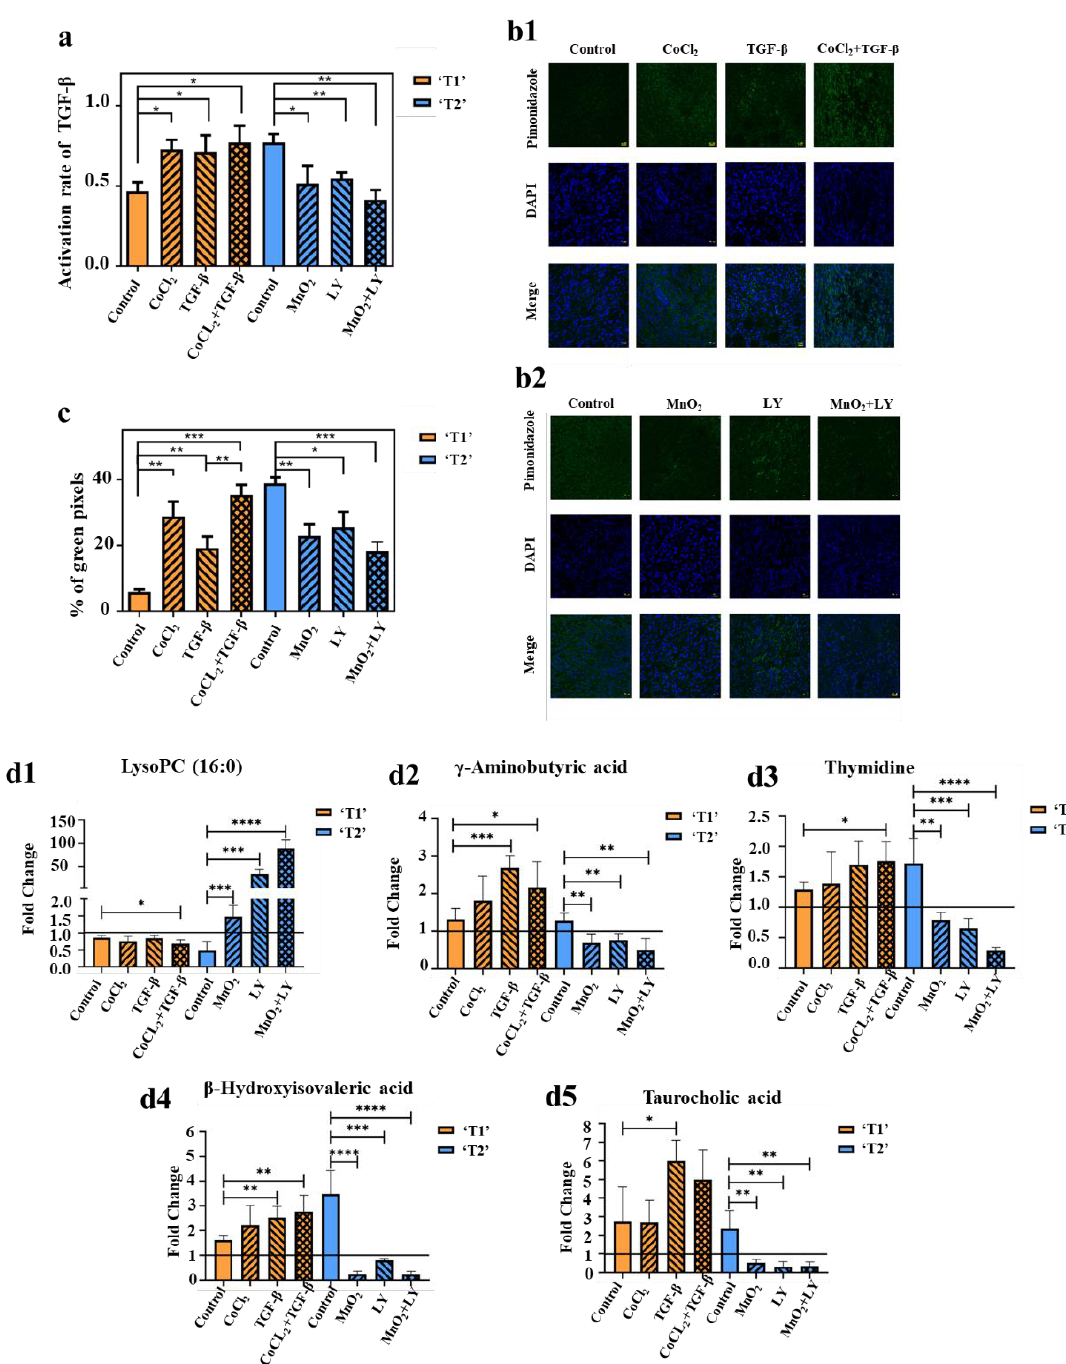
Figure 5. ( a ) TGF- β levels in tumor were determined by ELISA. The value of the activation rate is the ratio of the active TGF- β to the latent TGF- β ( n = 5/group). ( b1 , b2 ) Pimonidazole staining of tumors in stage ‘T1’ ( b1 ) and stage ‘T2’ ( b2 ) ( n = 5/group). ( c ) Hypoxic region that was stained by pimonidazole is shown in green fluorescence signal. The values represent the ratio of the sum of green pixels to the total tumor area in each image ( n = 5/group). ( d1 – d5 ) Fold changes of the contents of lysoPC (16:0) ( d1 ), γ -Aminobutyric acid ( d2 ), thymidine ( d3 ), β -hydroxyisovaleric